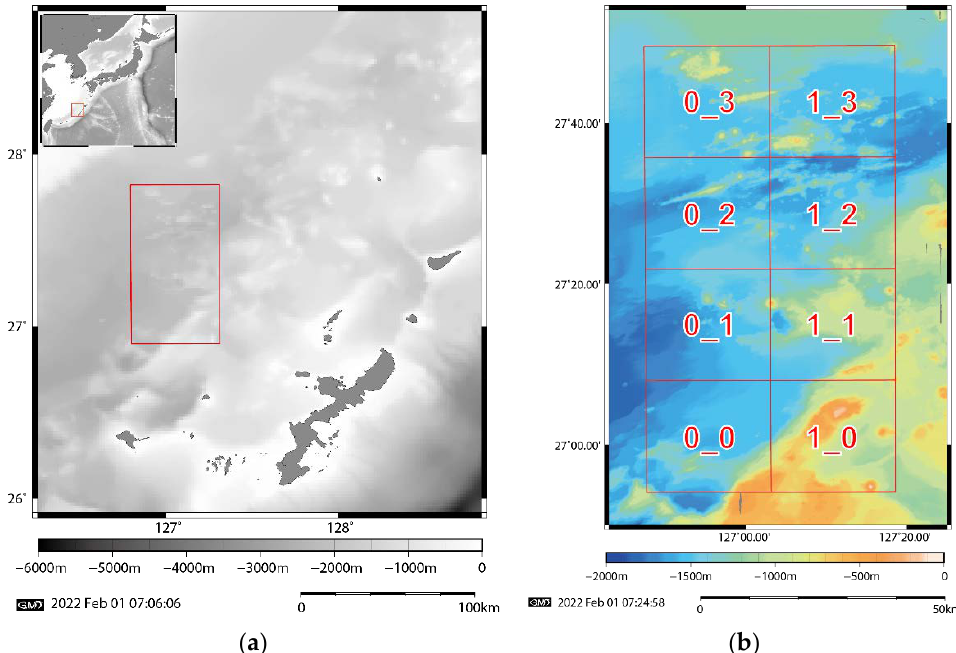
Figure 3. Map of the area used in this study. ( a ) The Japanese Islands (top left) and the sea around Okinawa; ( b ) Topographical map in the red box in ( a ). The area is equally divided into eight squares. The ridge in the area 0_2 is the Iheya–Minor Ridge.